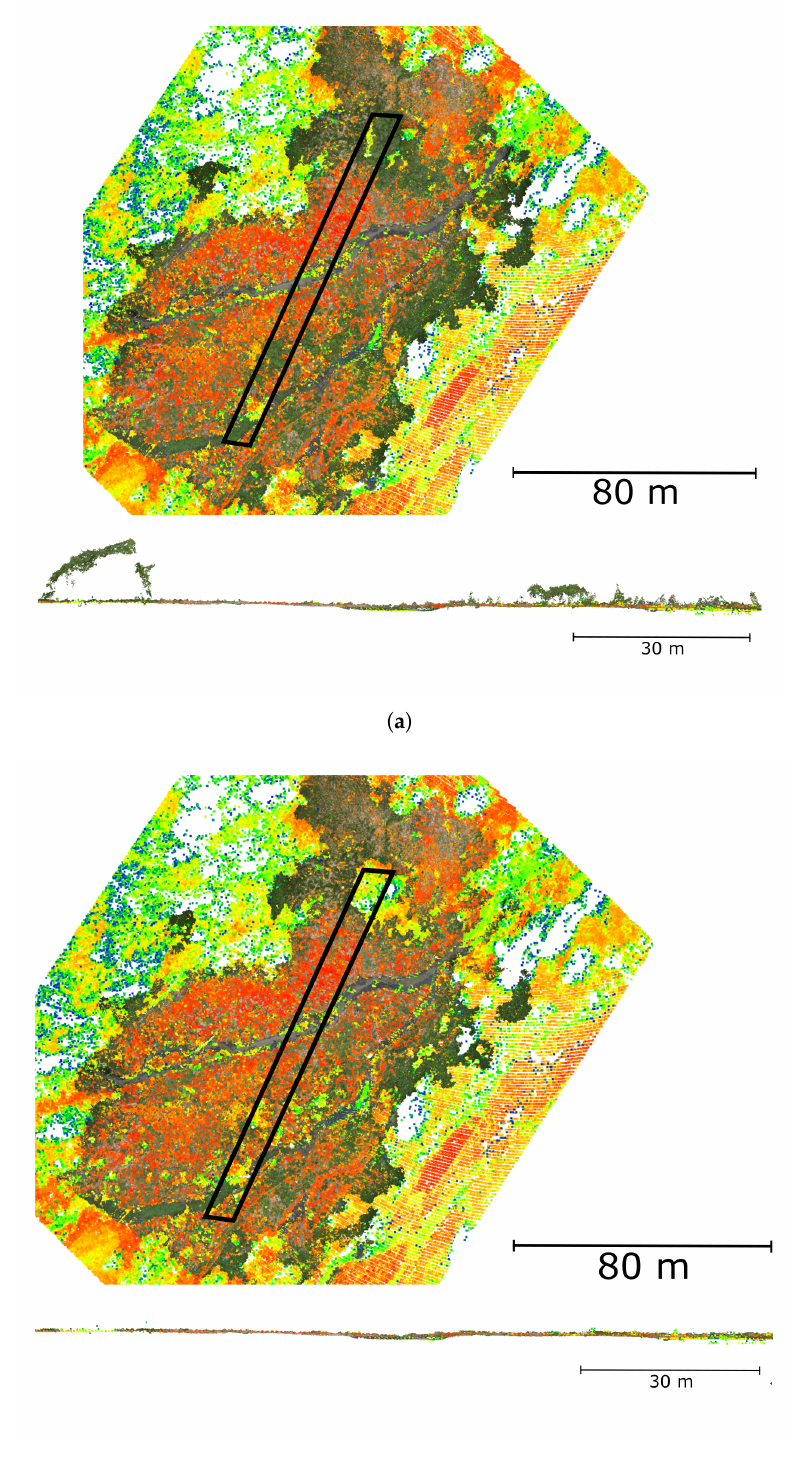
Figure 14. Registration of the multi-sensor data and influence of the outlier removal. Shown are a photogrammetric point cloud, generated from UAV taken images and the ground points of the LiDAR point cloud of the flight campaign of 2017. ( a ) Registration result of the proposed method shown on the unfiltered data as top down view. ( b ) Registration shown on the filtered data as top down view. The marked areas locate the profile views which show the outlier removal in where successful vegetation points inside the photogrammetric data are